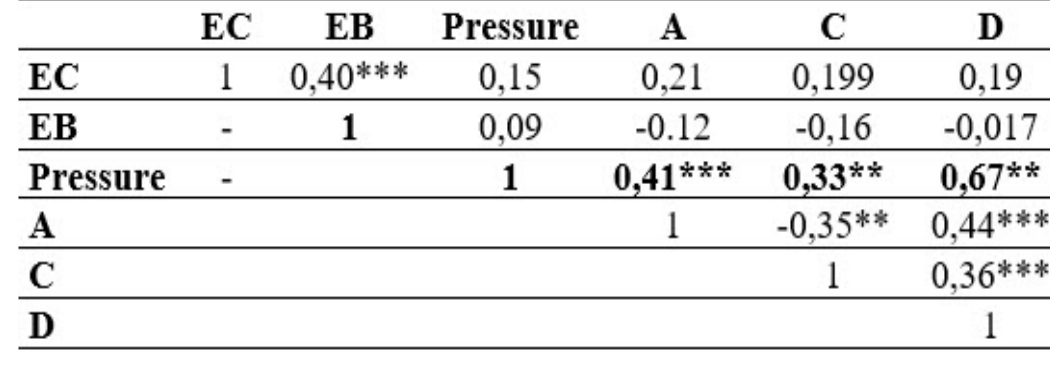
Table 1. Correlation and intercorrelation between the variables of emotional intelligence: emotional awareness (EA), emotional regulation (ЕR), stress (S) and the variables of mental health: aggressiveness (A), confidence (C) and depravation